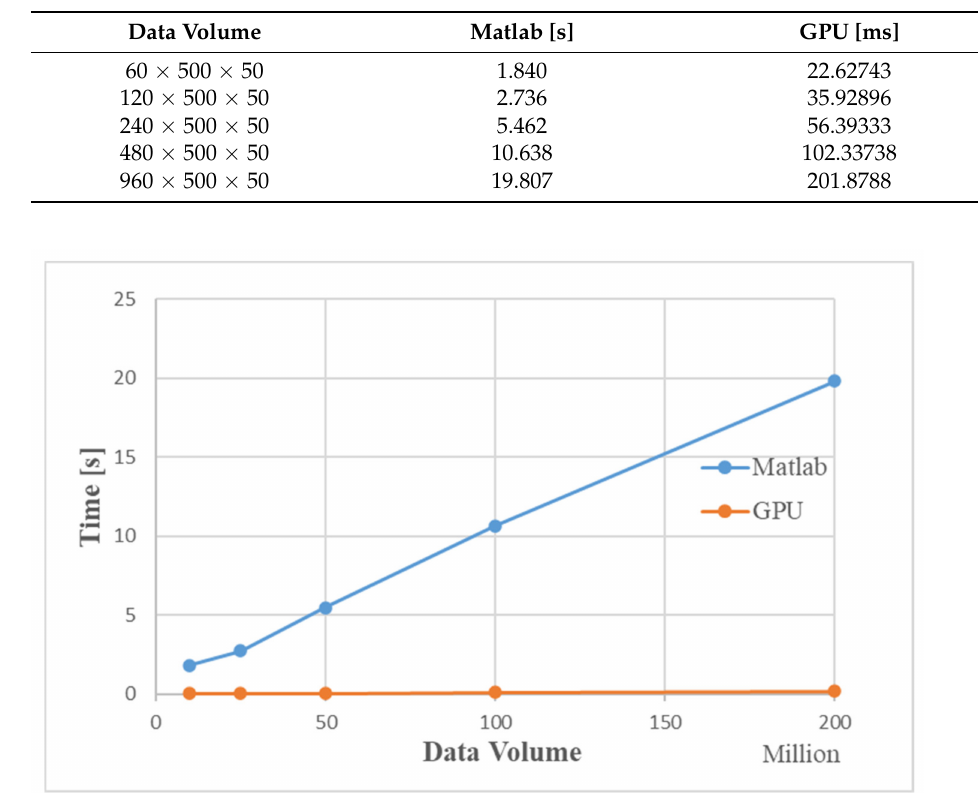
Figure 15. Comparison of time used by GPU and